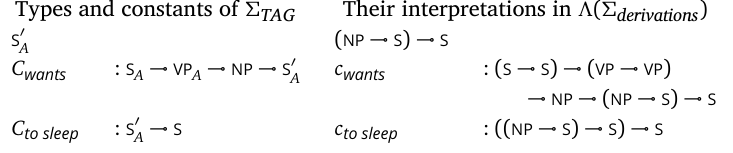
Table 15: G derived trees extension – control verbs Table 16: (cid:6) G sem. logic and extension – control